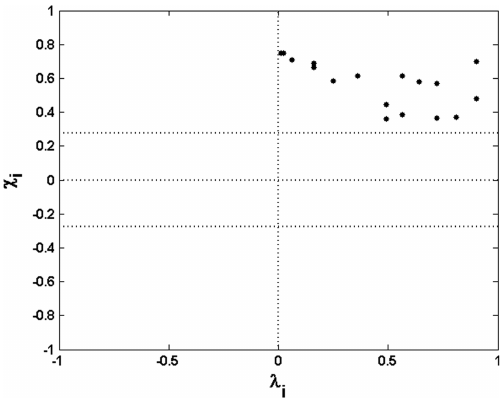
Fig. 7. Upper tail dependence analysis based on